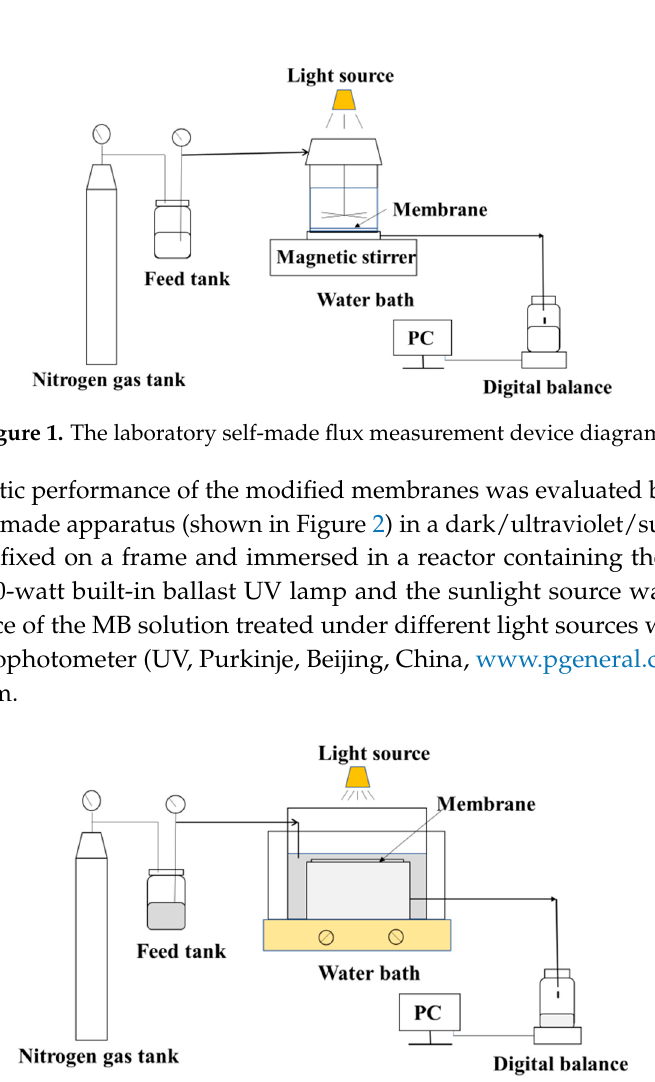
Figure 2. The laboratory self-made methylene blue degradation device.